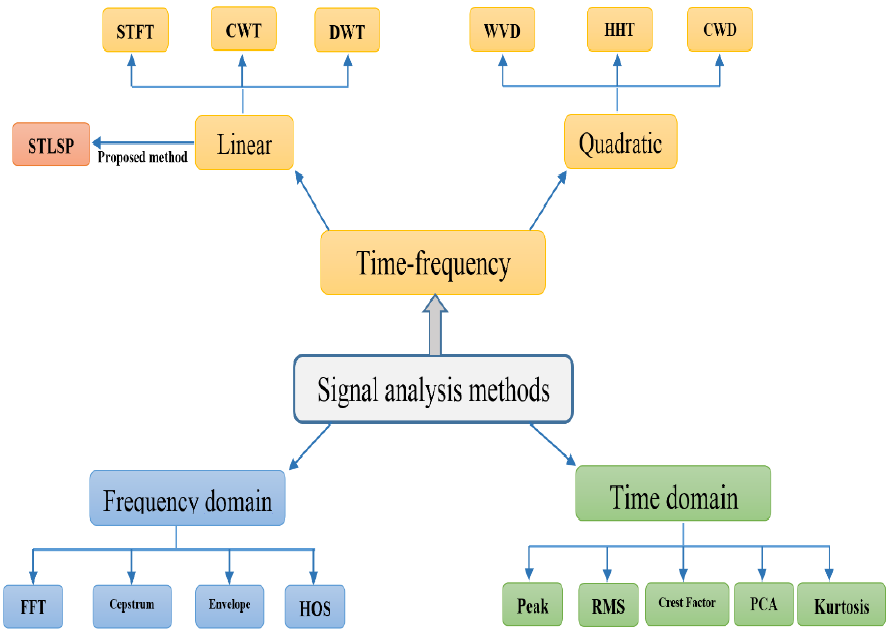
Figure 1. Classification of signal-analysis-based diagnostic techniques for AC motor drives.